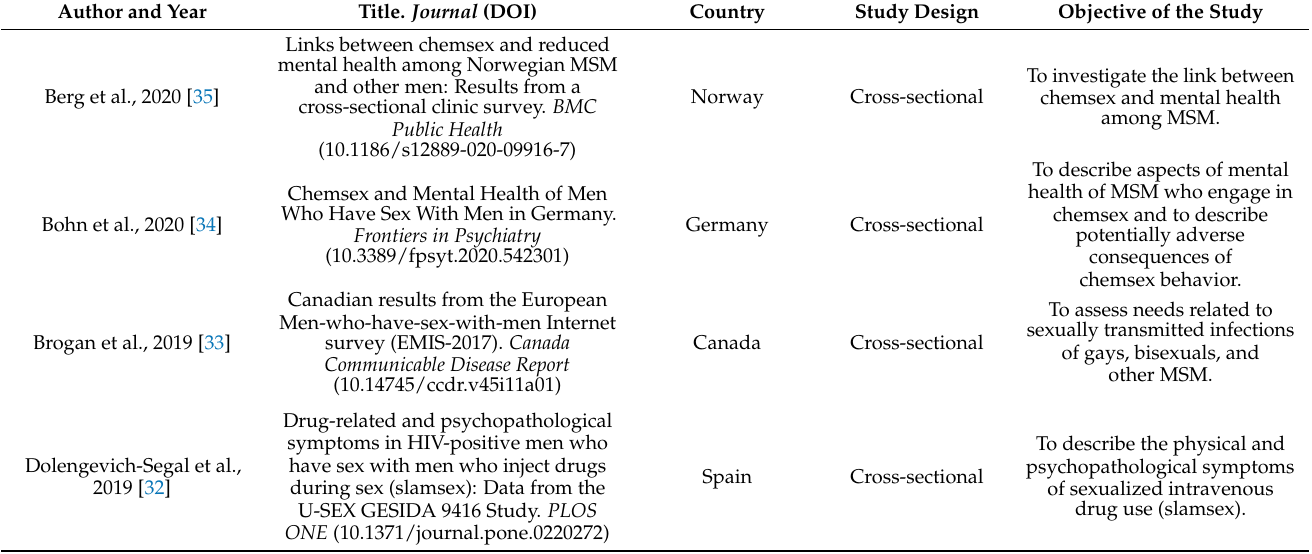
Table 1. Descriptive characteristics of included